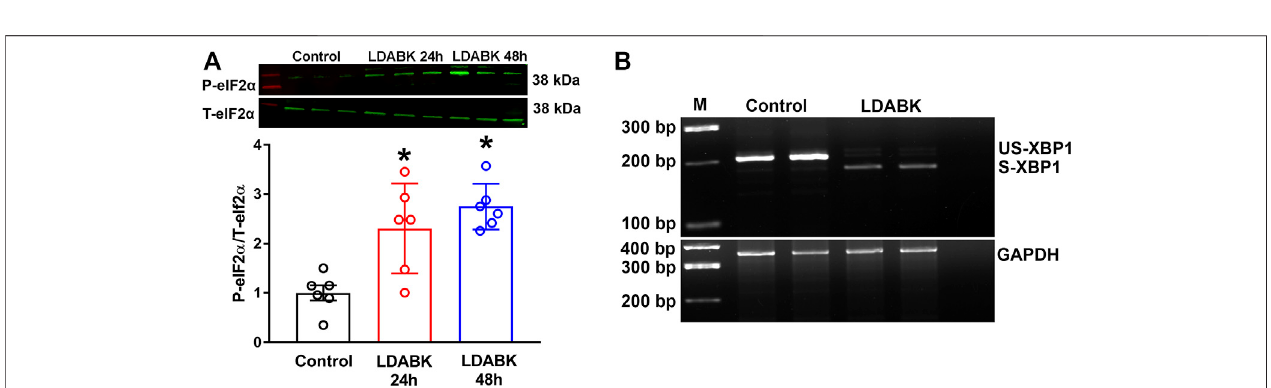
FIGURE 3 | B1R activation increases phosphorylation of eIF2 α and splicing of XBP1 mRNA. (A) Quantitative western blot analysis illustrates LDABK (300 nM) treatmentincreasesthephosphorylationofeIF2 α inneurons. * p < 0.05,comparedtocontrol. n =6/group. (B)